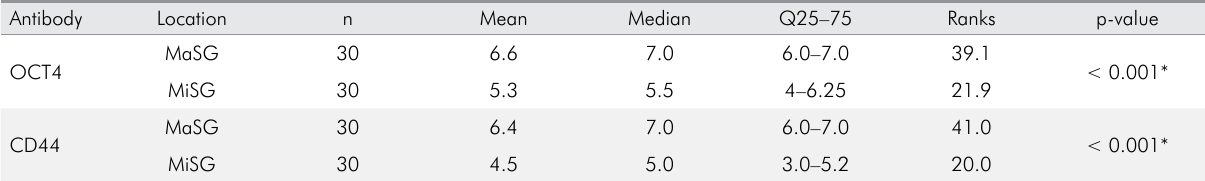
Table 1. Evaluation of OCT4 and CD44 immunoexpression according to anatomical location (MaSGs and MiSGs).